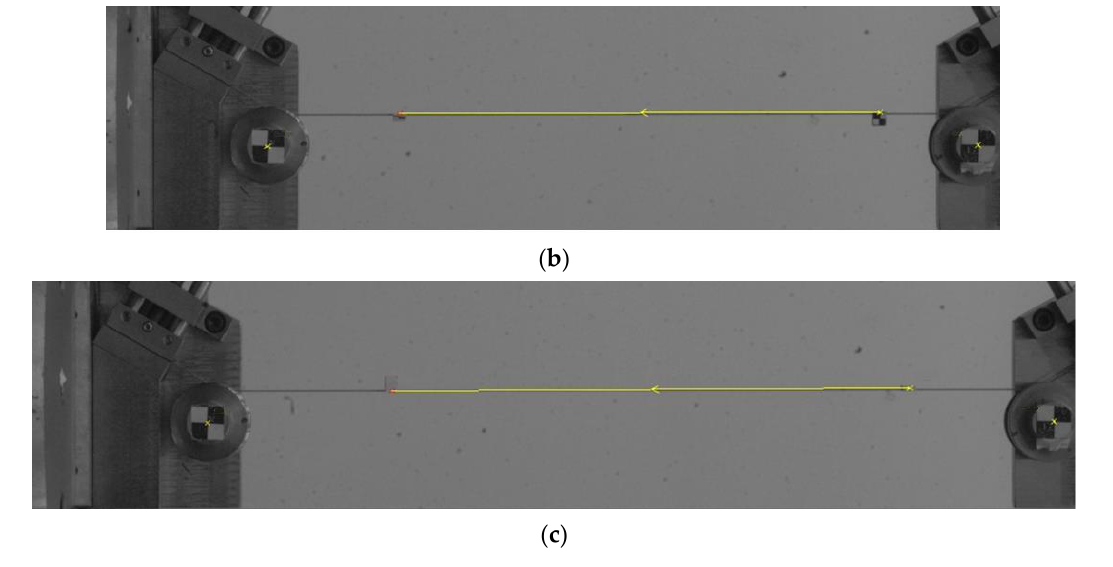
Figure 9. Photos of tested sample of cord I during strain measurement with DIC method: ( a ) at beginning of test, ( b ) halfway through test and ( c ) just before breaking.